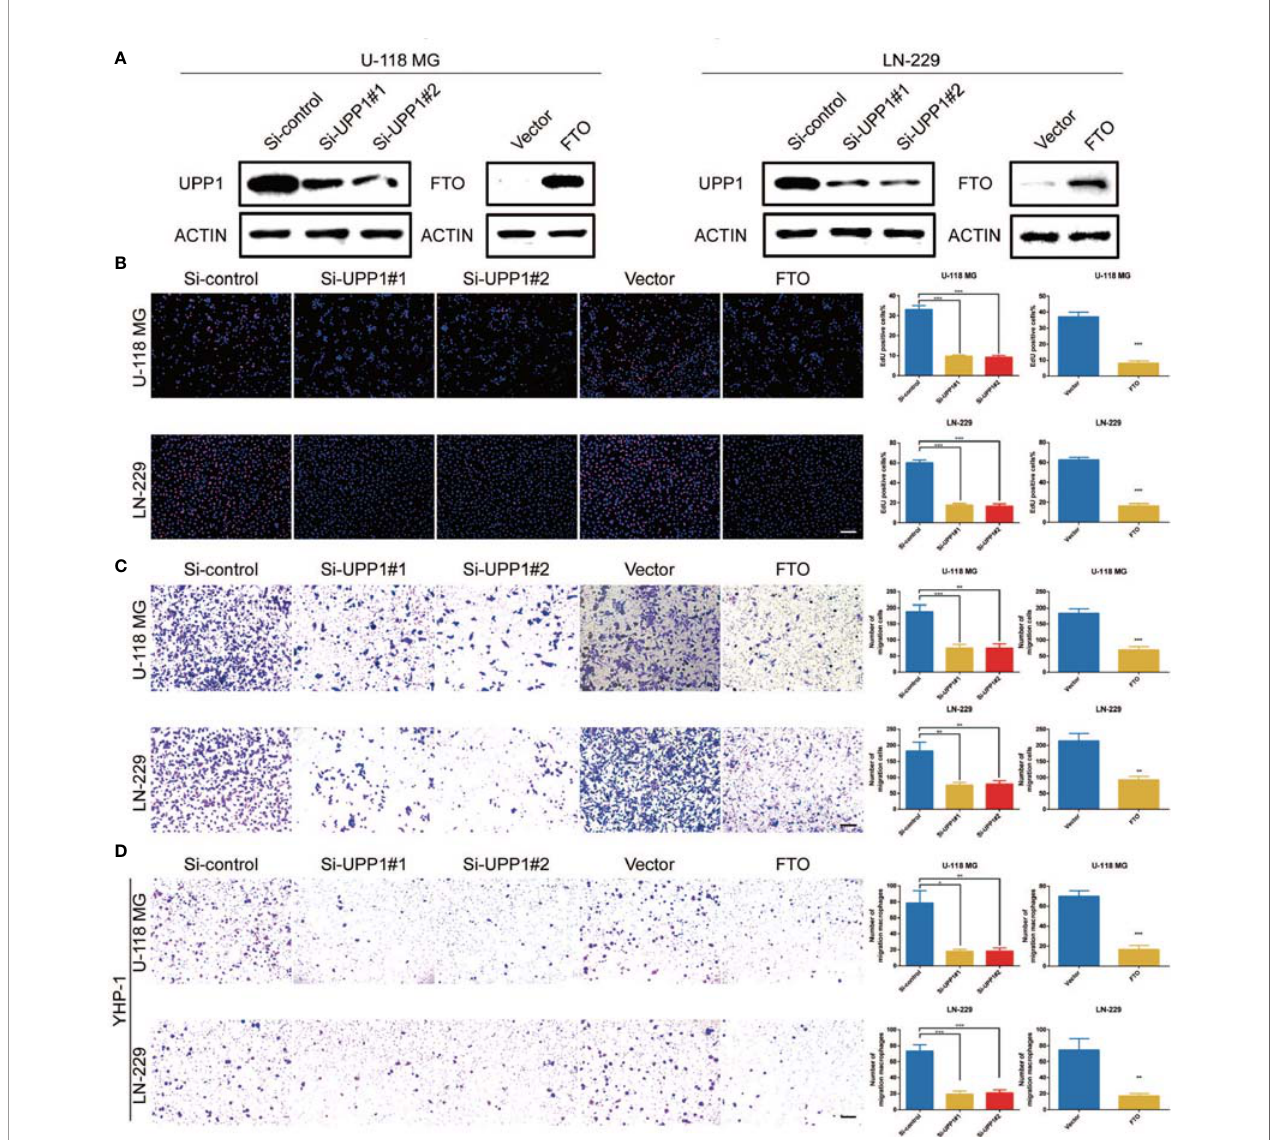
FIGURE 4 | UPP1 knockdown and FTO overexpression inhibit cell proliferation, migration, and macrophage recruitment. (A) Western blot analysis was performed to assess the expression levels of UPP1 and FTO. ACTIN was used as a loading control. (B) EdU was performed in U-118 MG and LN-229 transfected si-control, si-UPP1#1, si-UPP1#2, vector, and ov-FTO cells (scale bar = 100 m m). (C) Transwell assay performed in U-118 MG and LN-229 transfected si-control, si-UPP1#1, si-UPP1#2, vector, and ov-FTO cells (scale bar = 100 µm). (D) Transwell assays showed the ability of growth media of different GBM cells to recruit macrophages (scale bar = 100 µm). * means P<0.05; ** means P<0.01; *** means